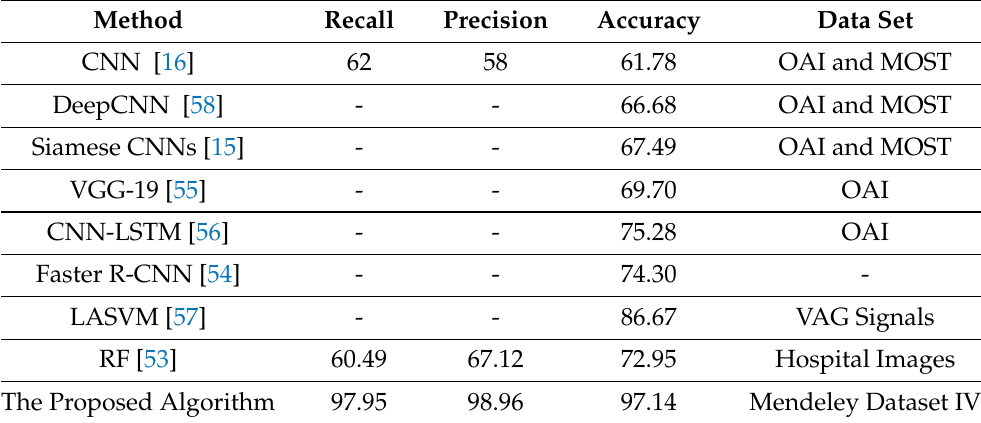
Table 9. Comparison of Different Proposed Algorithms.